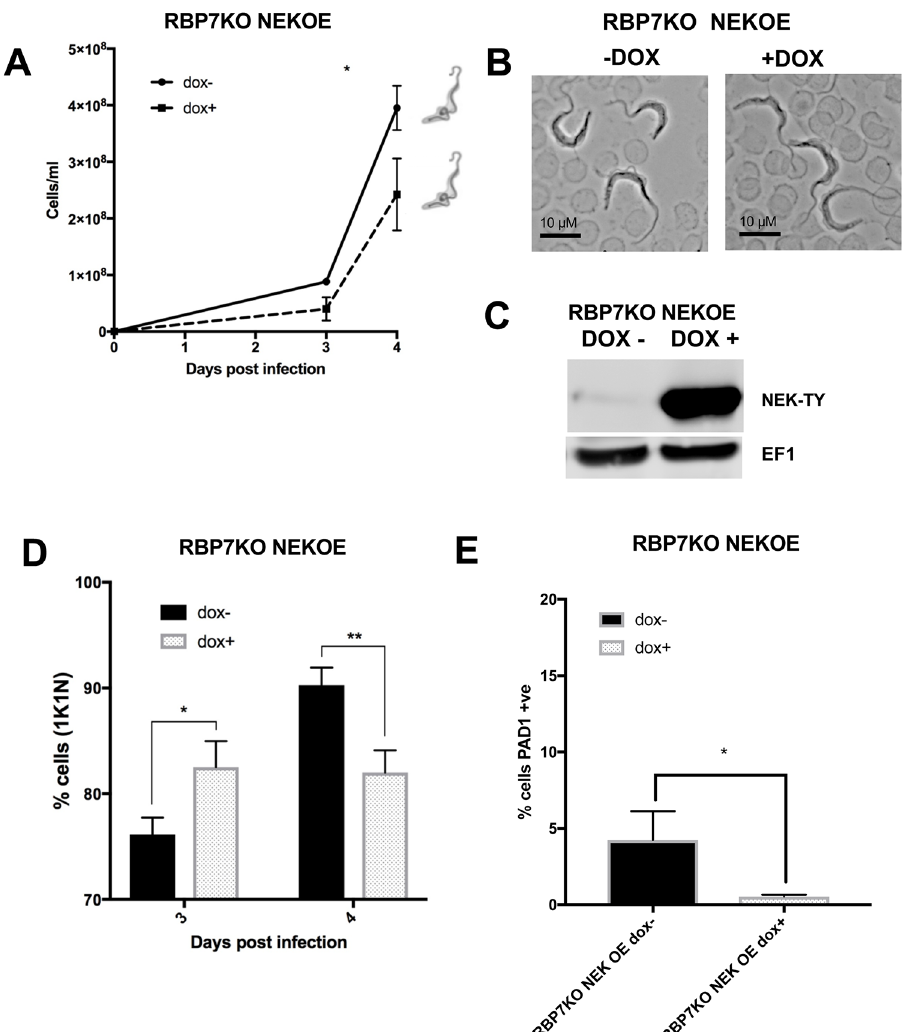
Fig 6. NEK17 induced differentiation is dependent on RBP7. A. Growth in vivo upon inducible ectopic expression of NEK17 in the RBP7AB null mutant. The dominant morphology of the cells on day 4 is shown schematically. Induced (+dox; ■ ), uninduced (-dox; ● ) over 4 days growth. B. Morphology of RBP7AB null mutants induced, or not, to ectopically express NEK17. Samples were isolated on day4 of infection. Bar = 10 μ m. C. Western blot demonstrating inducible ectopic expression of NEK17 in the RBP7AB null mutant. + dox, induced; -dox, uninduced. Elongation factor 1 alpha (EF1) provides the loading control. D. % 1K1N cells upon inducible ectopic expression of NEK17 in the RBP7AB null mutant at day 3 and day 4 post infection ( (cid:3) p < 0.05; (cid:3)(cid:3) p < 0.005). E. % PAD1 cells upon inducible ectopic expression of NEK17 in the RBP7AB null mutant at day 4 post infection ( (cid:3) p < 0.05). Less PAD1 expression is detected in the NEK OE due to their lower overall parasitaemia than in the uninduced population (Fig 6A) with respect to RBP7AB KO cells alone (Fig